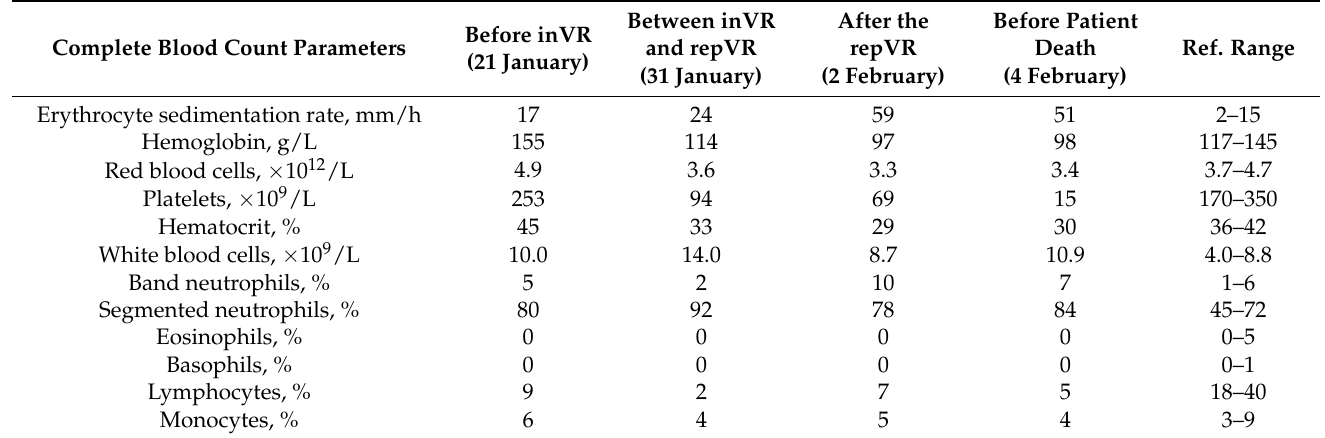
Table 2. Complete blood count before the mitral valve replacement, between initial and repeated valve replacement, and before the fatal